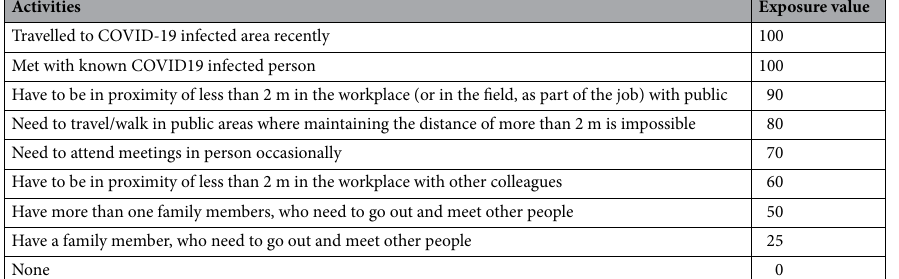
Table 5. Proximity and exposure value.